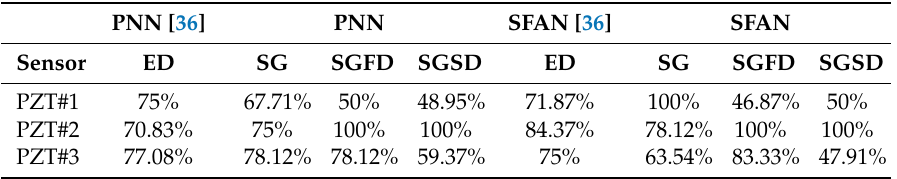
Table 1. Success rates for Probabilistic Neural Network (PNN) and Simplified Fuzzy ARTMAP (SFAN) methods for the real part of the EMI (frequency